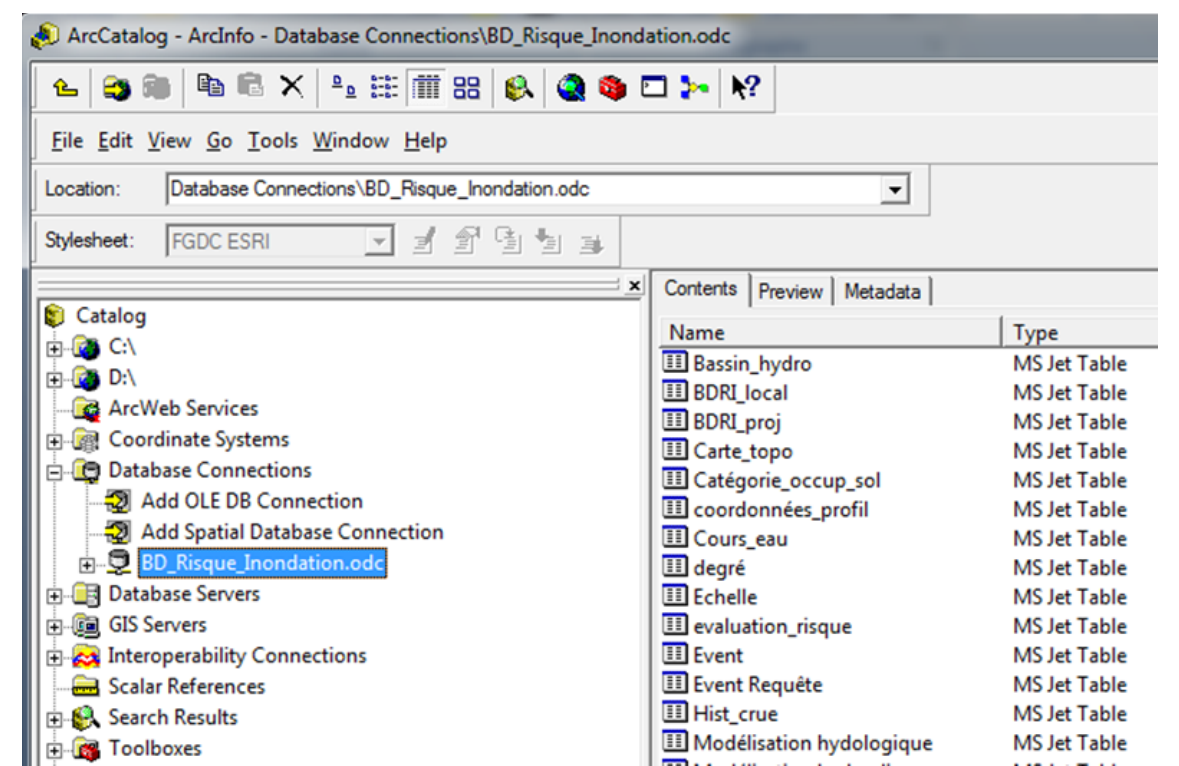
Fig. 4: View of the ArcGis software showing the ODBC connection with MS-Access